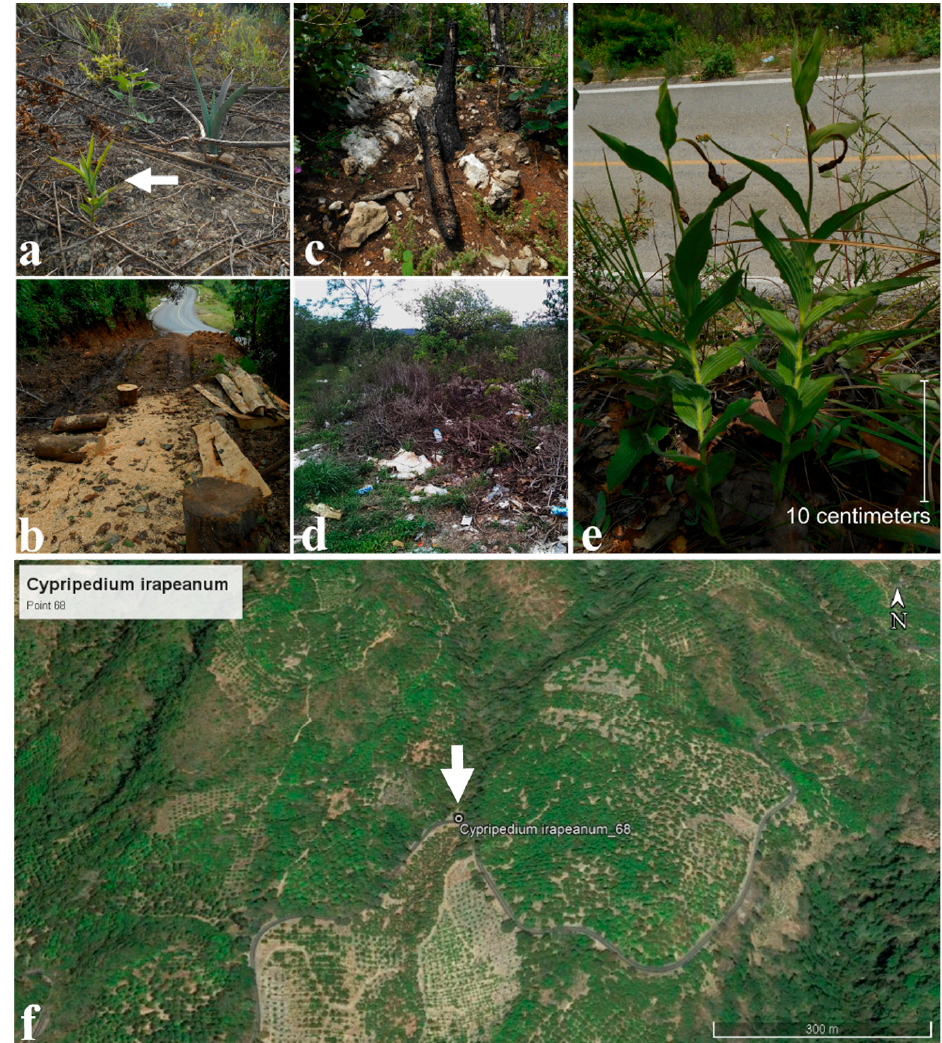
Figure 3. Destroyed habitats of Mesoamerican Cypripedium molle in Oaxaca State ( a – d ) and C. irapeanum in Nayarit State ( e – f ). ( a ) Land use change for Agave angustifolia cultivation for mezcal production (white arrow indicates a remaining C. molle plant). ( b ) Deforestation of a pine forest in the transition from oak to cloud forest habitat. ( c ) Fire destruction of oak forest habitat in limestone. ( d ) Habitat destruction by an outdoor dump. ( e ) Population vulnerability next to the road subject to any perturbation process. ( f ) Land use change of deciduous forest transitions for mango cultivars (white arrow shows the disappeared population). ( a – e ), photos taken by Mauricio Moreno in 2019; ( f ), INEGI [23] and Google Earth ©, 2020.